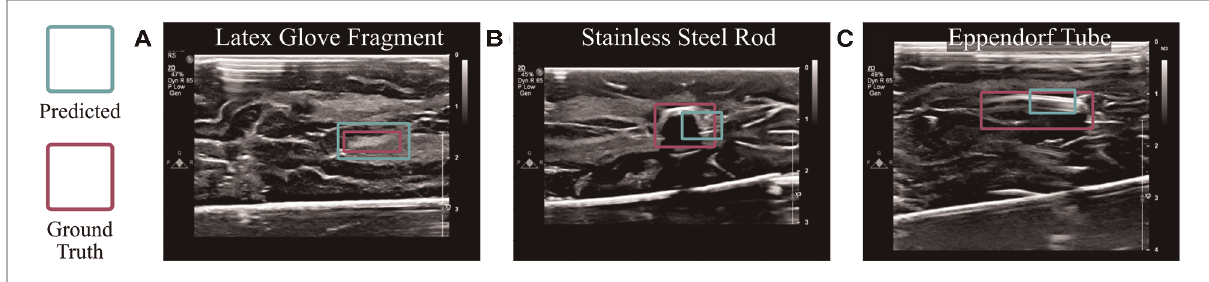
FIGURE 9 Algorithmic implementation using other materials. The trained model, without any changes, was used to detect ( A ) latex glove fragments, ( B ) a stainless steel rod, and ( C ) an Eppendorf tube implanted into the brain.